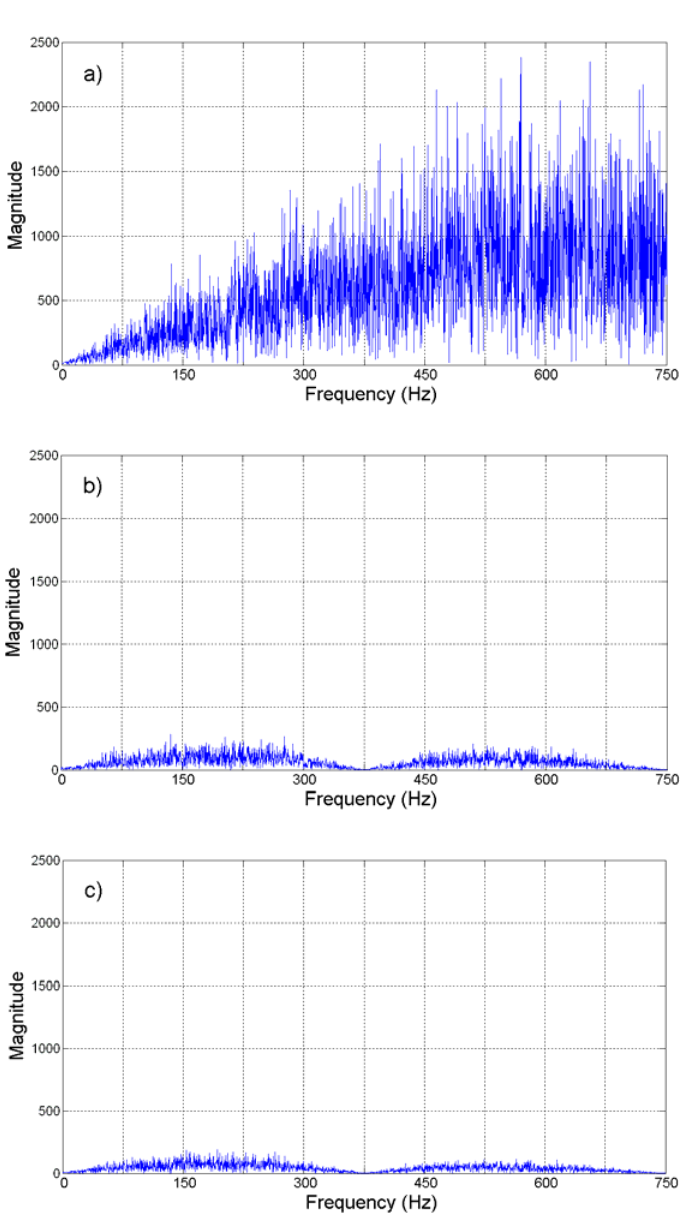
Figure 17. Averaging decimation jerk error spectra. (a) Nyquist rate. (b) 4-times oversampling. (c) 8-times oversampling. (d) 16-times oversampling. (e) 32-times